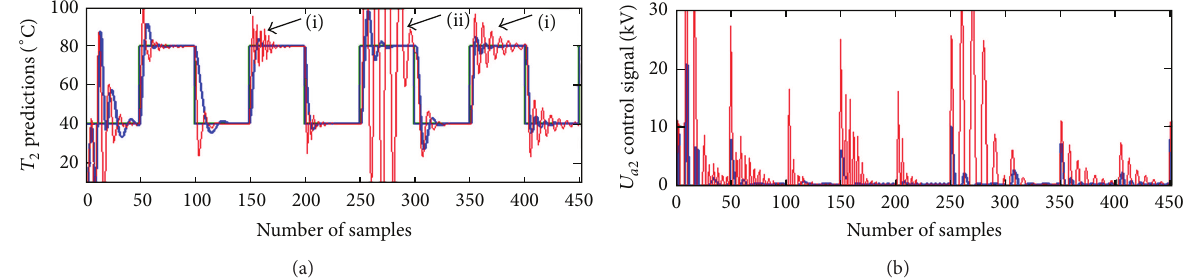
Figure 10: Temperature control in first pickling bath under model mismatch case by GPC (red) and DNN-ADNMPC (blue).